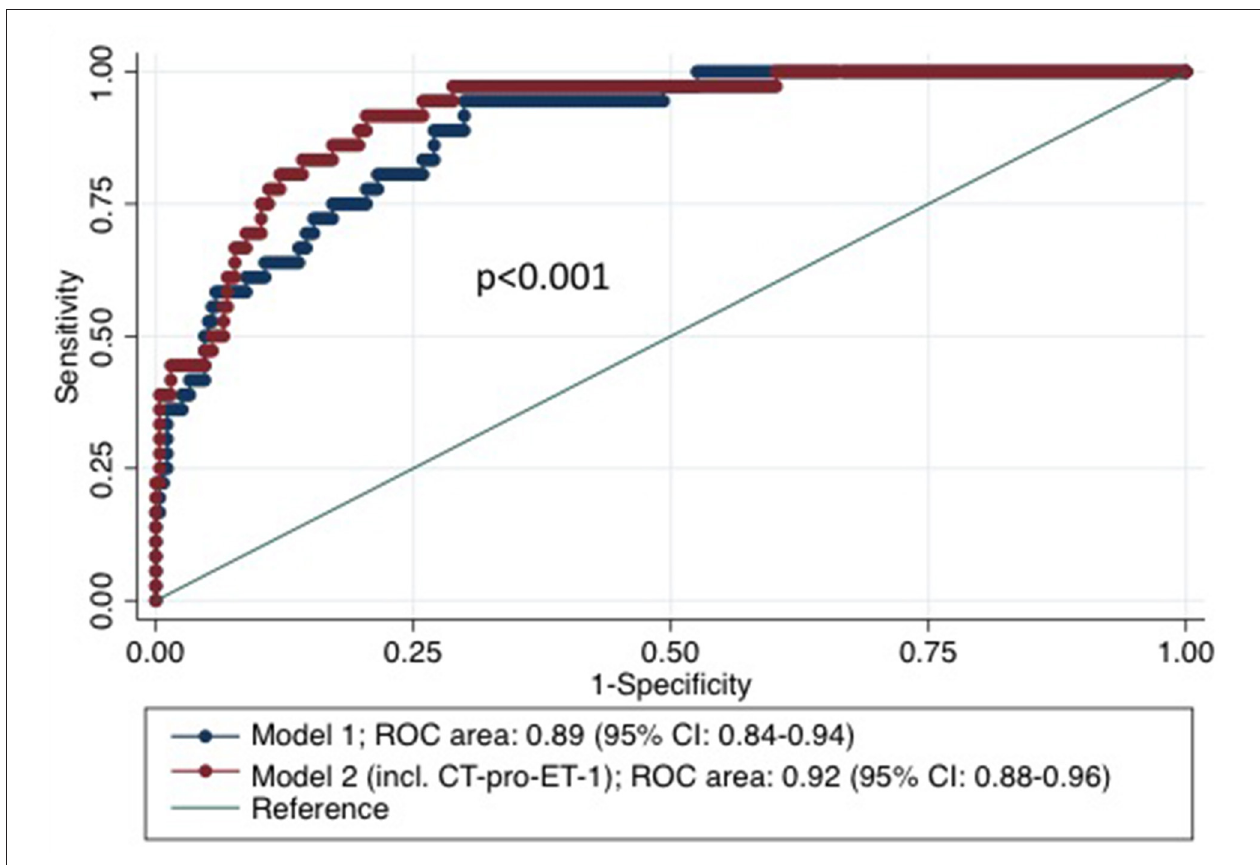
FIGURE 2 | Receiver Operator Characteristic (ROC)-curves based on regression models for mortality within 3 months after stroke with and without CT-pro-ET-1. Model 1 represents the cox proportional hazards model for mortality within 3 months after stroke including the risk factors age and NIHSS on admission. Model 2 represents the analysis adding CT-pro-ET-1 on day 1 after admission to the